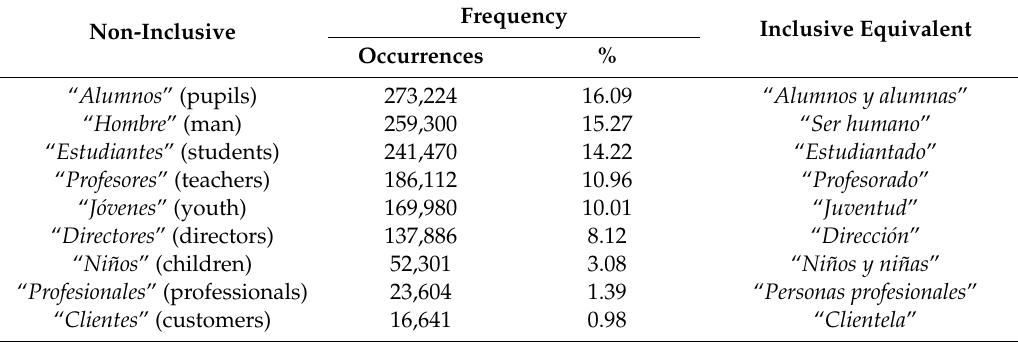
Table 12. Most common non-inclusive